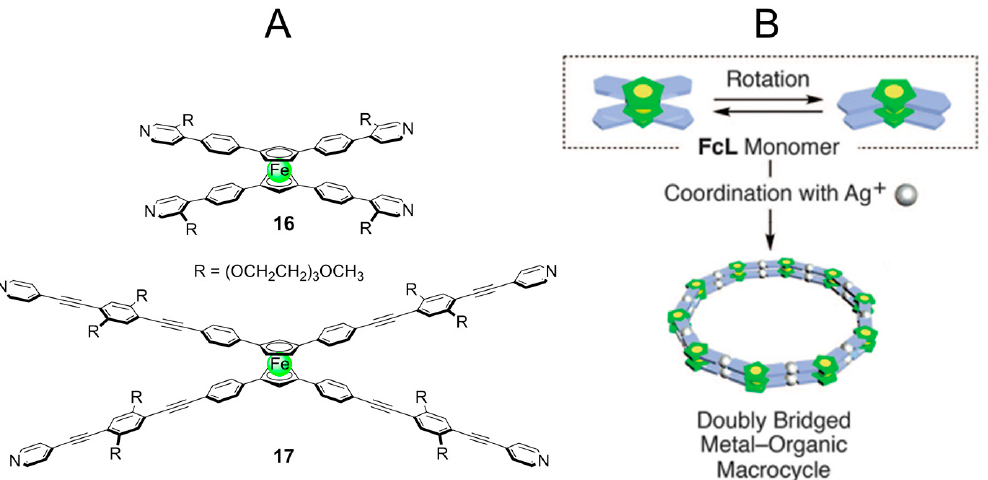
Figure 13. ( A ) Building blocks used for construction of NTs; and ( B ) schematic illustration of